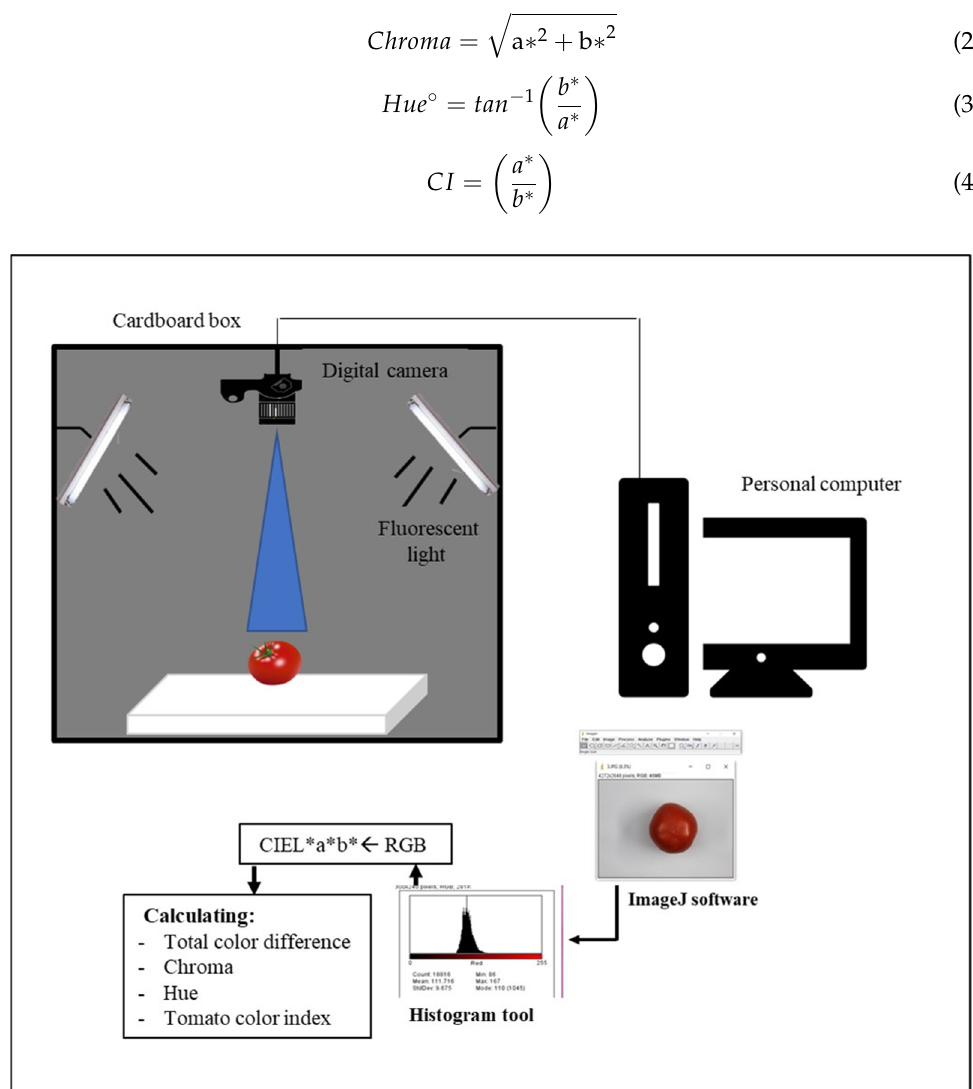
Figure 1. A schematic diagram of computer vision